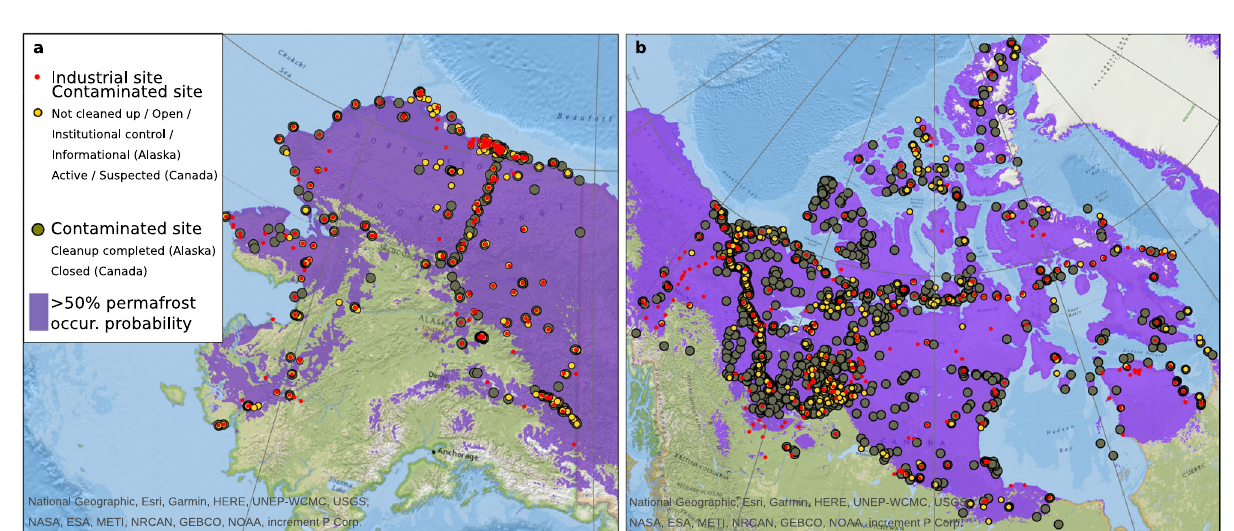
theNationalGeographicWorldMap 58 .Ourclassi fi cationCleanupcompleteandNot cleaned up refers to information on whether hazardous substances have been removed or remain (or are suspected to remain) in the environment. Maps were created by using ArcGIS version 10.5 (Esri Inc., USA).